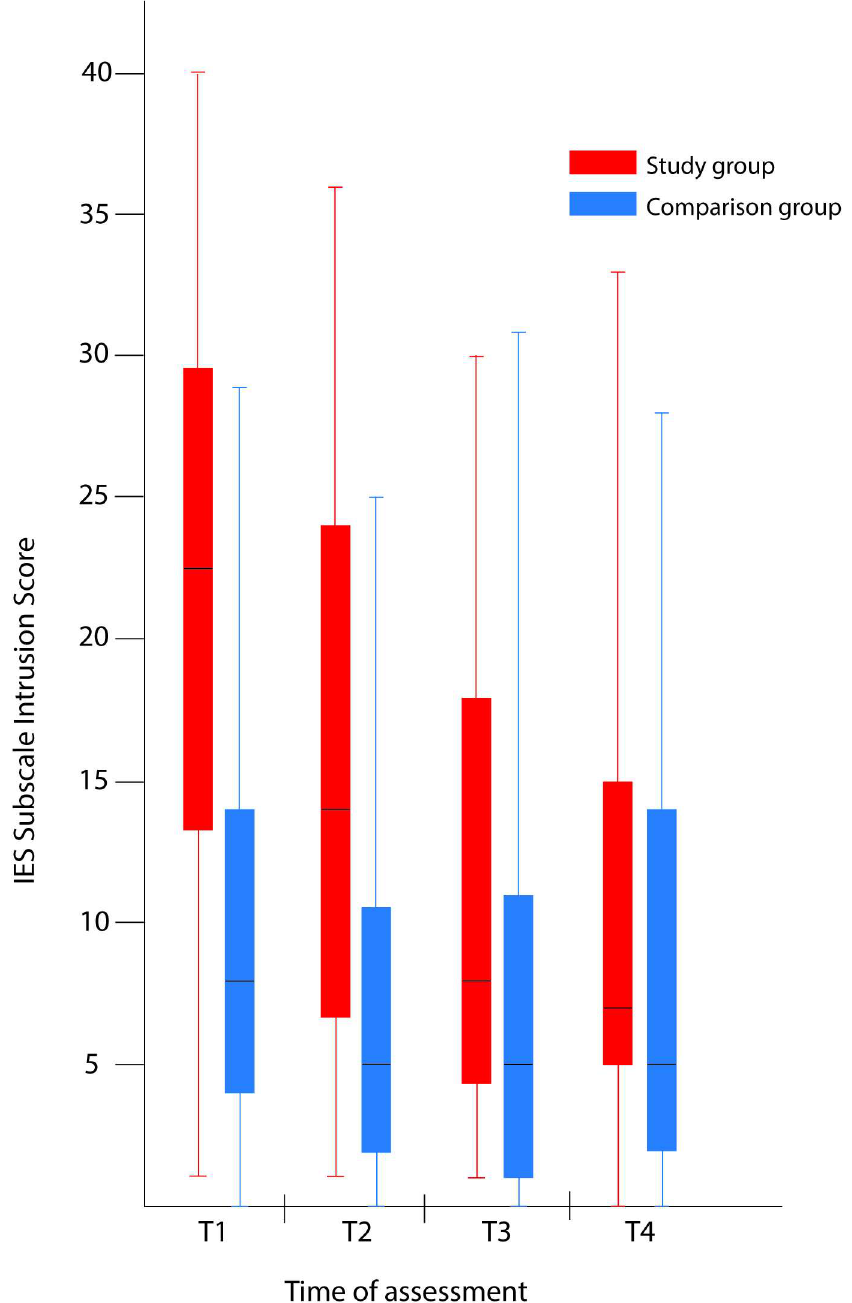
Fig 1. Comparison of maternal psychological distress during pregnancy with and without a fetal anomaly. The figure presents psychologicaldistress in women in the study group (with fetal anomaly)and comparisongroup (normal ultrasound findings)at the four assessments, as measuredby the Intrusion subscaleof the Impact of Event Scale (IES). Box-and-whiskers plots show 50% of cases (25–75percentiles) in the rectangle, each of the whiskers represents the smallest and largest values. The line within the rectangle represents the medianvalue.